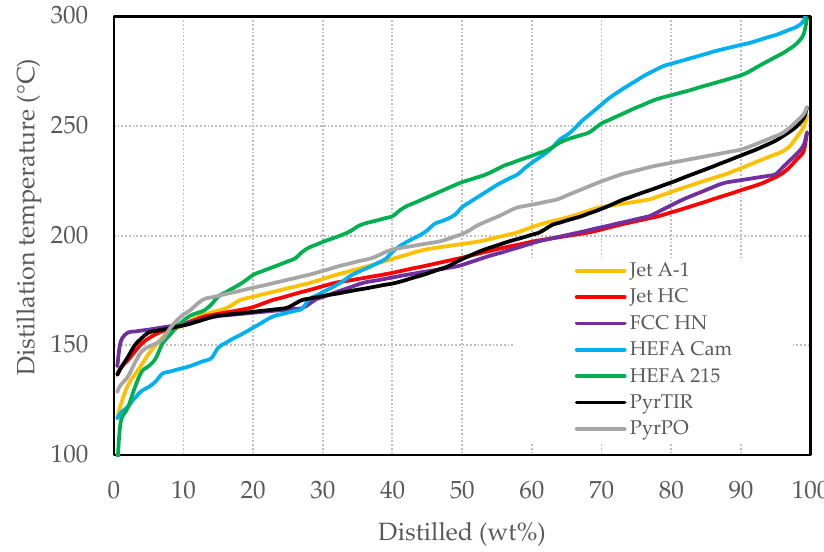
Figure 2. SimDist of the samples studied.